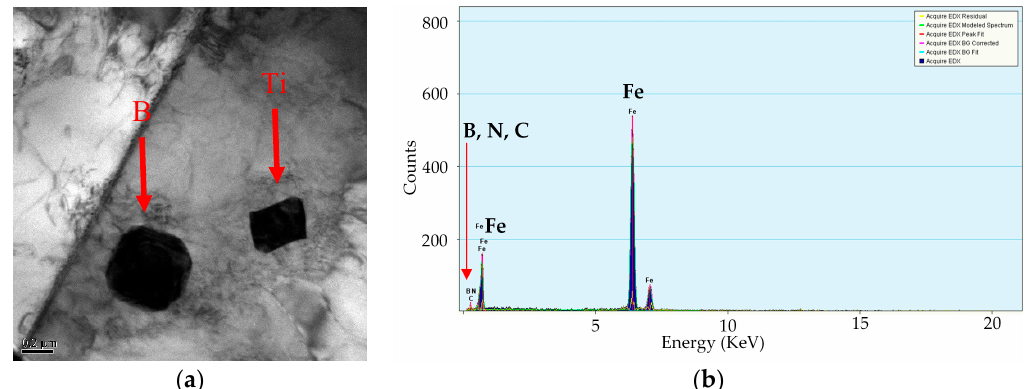
Figure 8. TEM image of S4 steel at the cooling rate 0.0038 °C/s. ( a ) carbide in ferrite grain; ( b ) energy dispersive spectrometer (EDS) of BN.